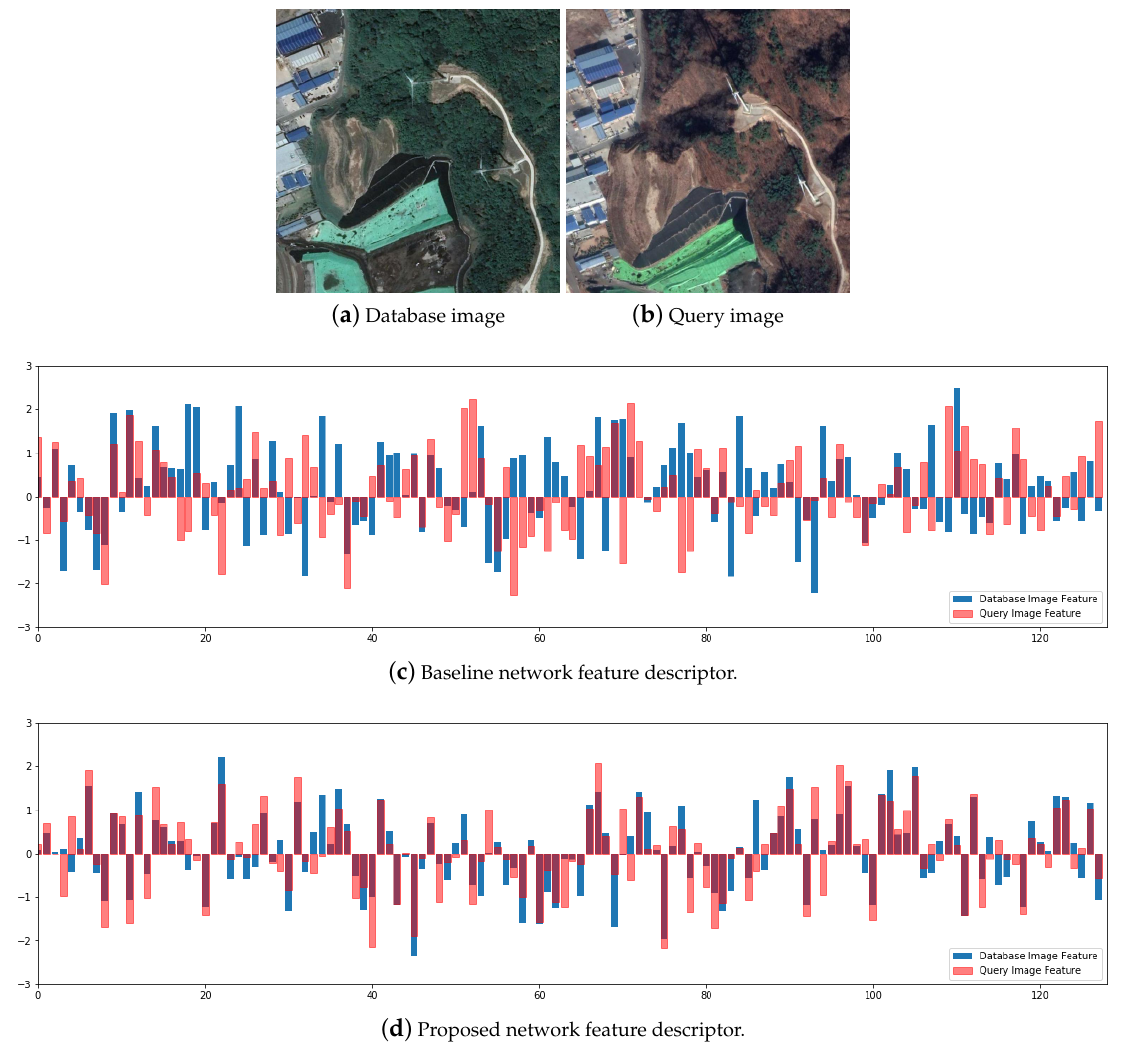
Figure 10. Visualization feature descriptors on the matching patch pairs of the database image and the query images. The two pictures on top were the database image and the corresponding query image, respectively. The graph in the second row shows the feature of the two images using the baseline model. The graph in the third row shows the features of the proposed coarse-to-fine trained